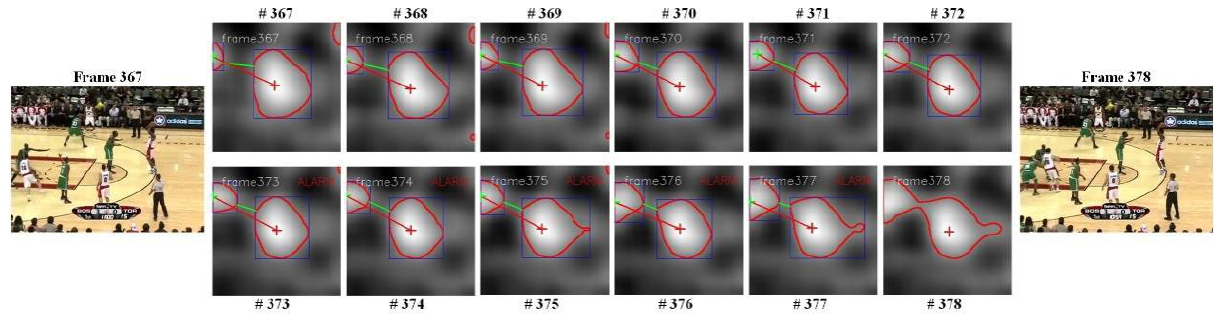
Figure 5. The process of distractor approaching analysis.